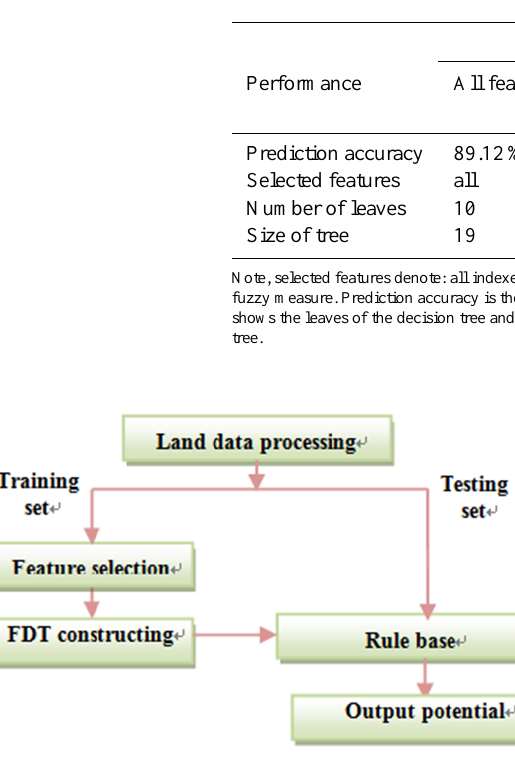
Table 5. The results from rough set selection and fuzzy measure selection.